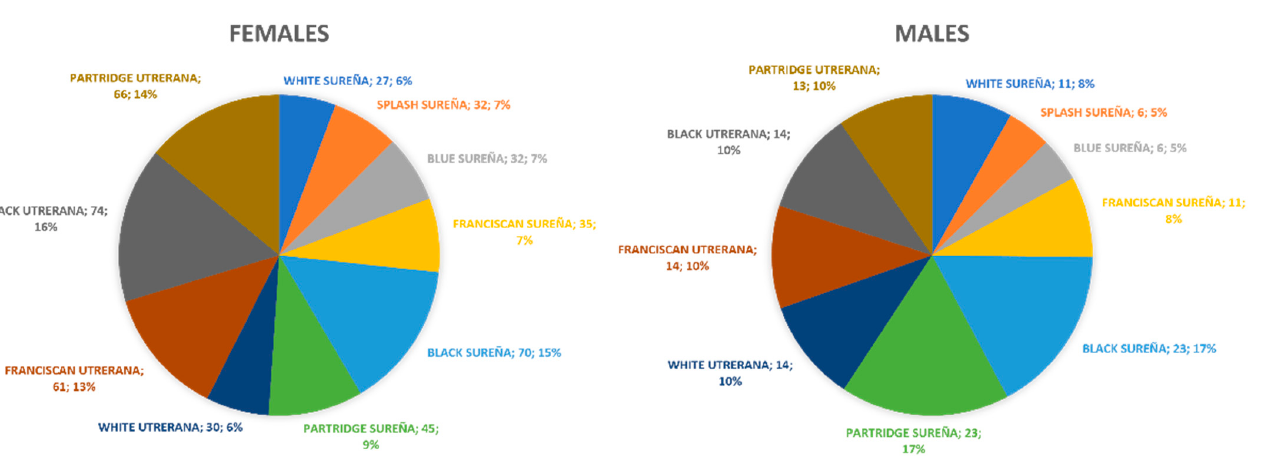
Figure 1. Percentage and number of individuals ( n ) used in each studied genotype. The sample was collected at 16 farms across the seven provinces in Andalusia (Cádiz, Córdoba, Granada, Huelva, Jaén, Málaga, and Sevilla). All animals were reared under ex- tensive backyard conditions.